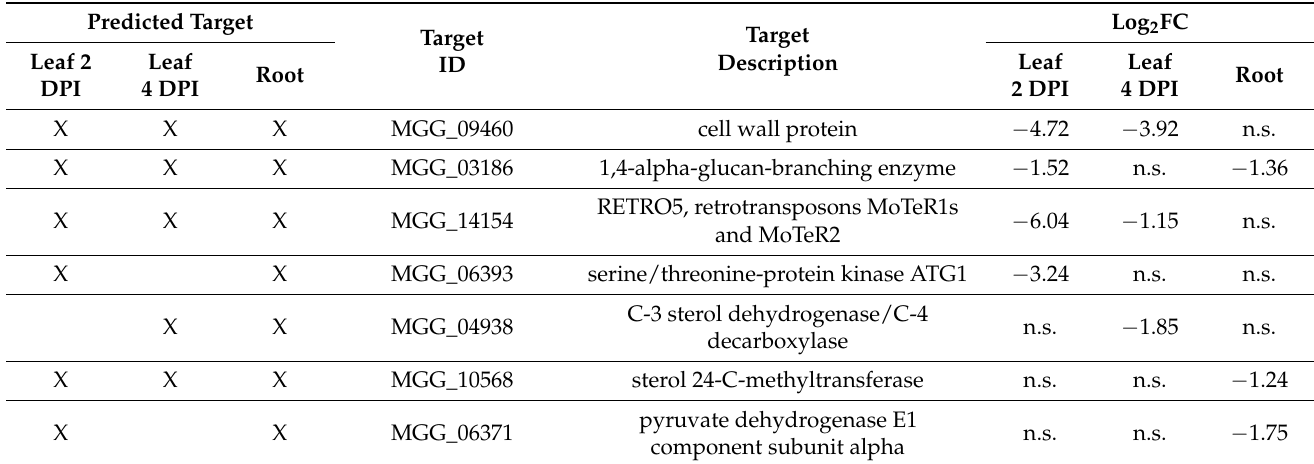
We searched the Pathogen-Host Interactions Database (PHI-base) for available infor- mation on loss-of-virulence mutants for the predicted Mo target genes. A list of down- regulated predicted Mo targets and corresponding PHI-base phenotypes is shown in Table 8. Of note, the predicted Mo genes are involved in virulence and pathogenicity, including CON7 transcription factor (MGG_05287) predicted to be targeted in the Mo- infected root, the effector AvrPiz-t (MGG_09055) predicted to be targeted in the leaf at 4 DPI and the vacuolar glucoamylase SGA1 (MGG_01096) predicted to be targeted in the leaf at 2 DPI. Additionally, potential targets shared between more than one setup included (MGG_00620), Sso1 (MGG_04090) encoding a SNARE protein and YHM2 (MGG_07201) encoding mitochondrial DNA replication protein (2 DPI leaf vs. root), as well as MoATG17 (MGG_07667) encoding an autophagy-related protein (biotrophic vs. necrotrophic leaves), whose respective mutants are also known to be compromised in pathogenicity [45,46] (Tables 7 and